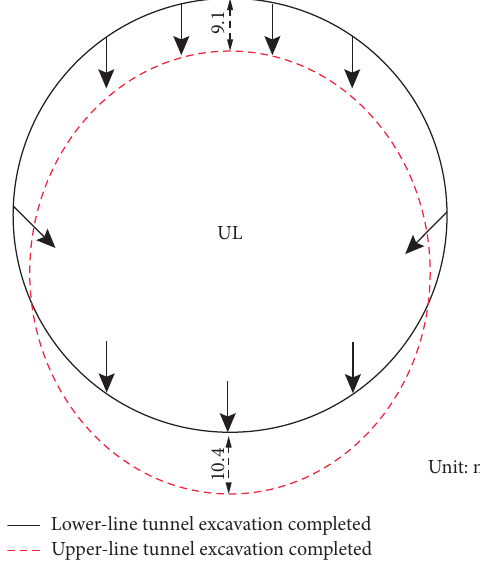
Figure 14: The lining deformation of the upper-line tunnel.